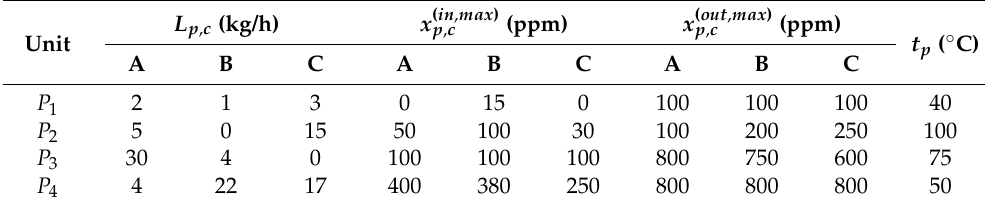
Table 5. Process water-using units data for Example 3.